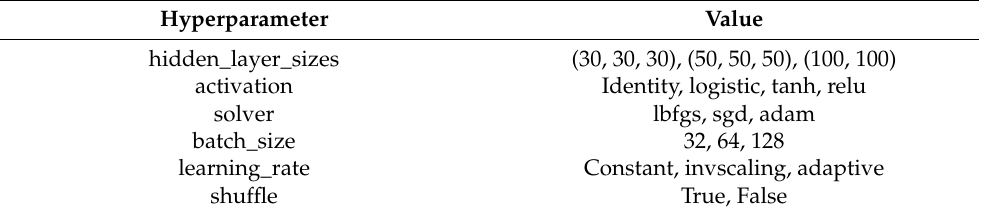
Table 5. Hyperparameters to determine the optimal values for multilayer perceptron regressor.